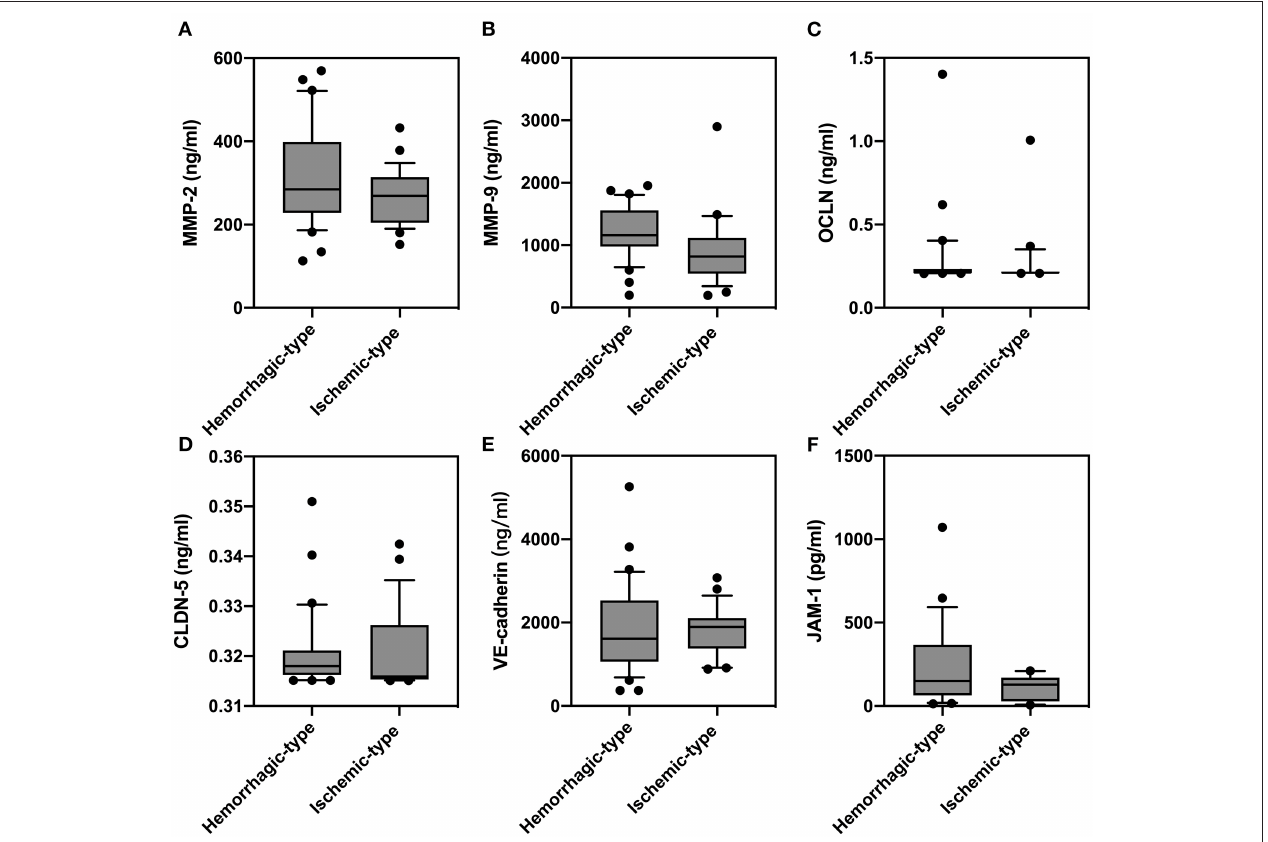
FIGURE 3 | Comparison of serum levels of matrix metalloproteinase (MMP)-2 (A) , MMP-9 (B) , occludin (OCLN) (C) , claudin-5 (CLDN5) (D) , vascular endothelial (VE)-cadherin (E) , and junction-associated molecule (JAM)-1 (F) between adult patients with and without spontaneous hemorrhages.